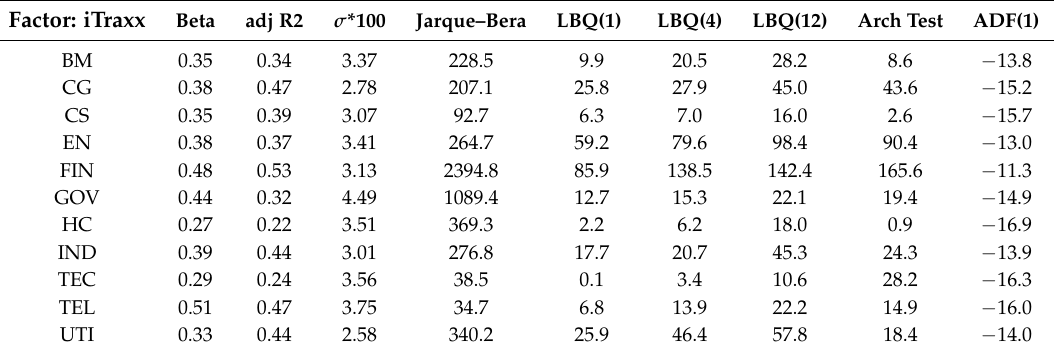
Table 5. One-factor Itraxx regressions explaining sectorial credit indices.